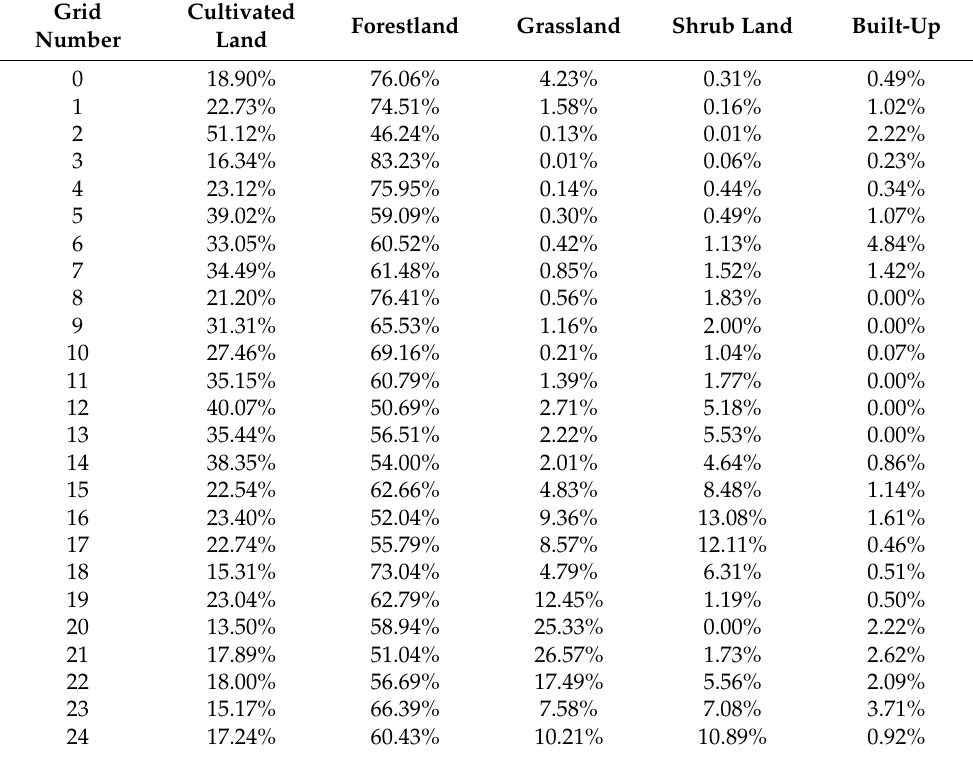
Figure 5. EVI of the movement route of Asian elephants. The figure was composed of three parts: ( a ) the spatial pattern of EVI, ( b ) the EVI change curve of recorded locations, and ( c ) the EVI change curve of the buffer grid from south to north. Table 1. Proportions of land use types on the Asian elephant movement